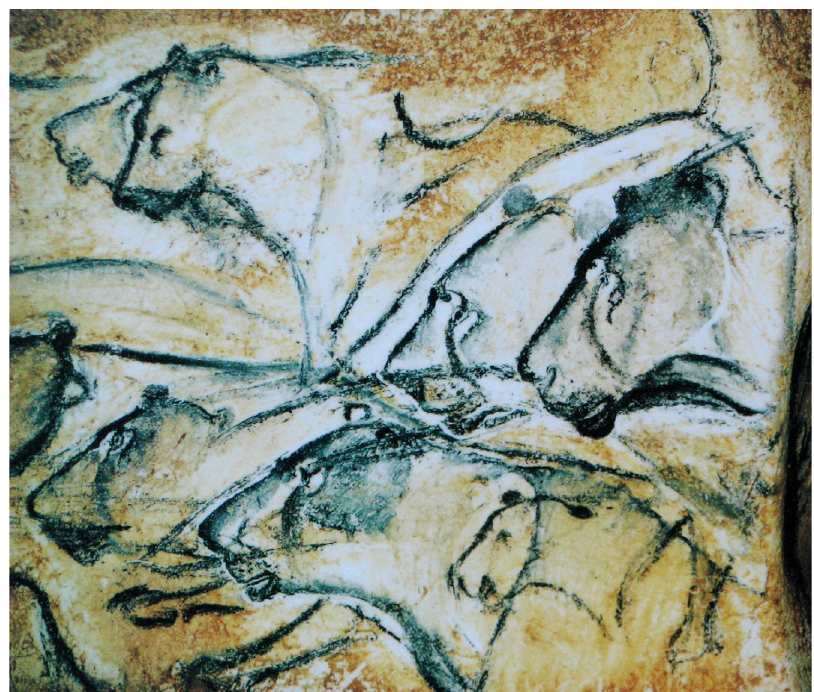
Figure 1. The frieze of lions at Chauvet Cave shows traits in common with the art of exceptionally talented individuals with autism, including exceptional realism, precise detail, a focus on parts rather than wholes and overlapping forms. Source: